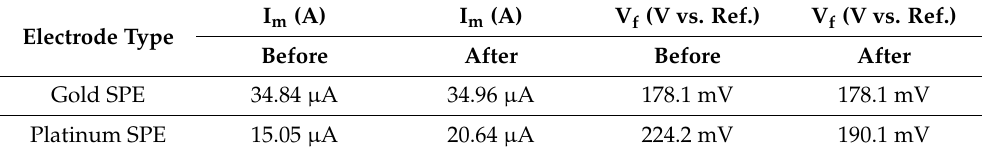
Table 3. Electrochemical measurements before and after exposure to absolute ethanol. Electrode